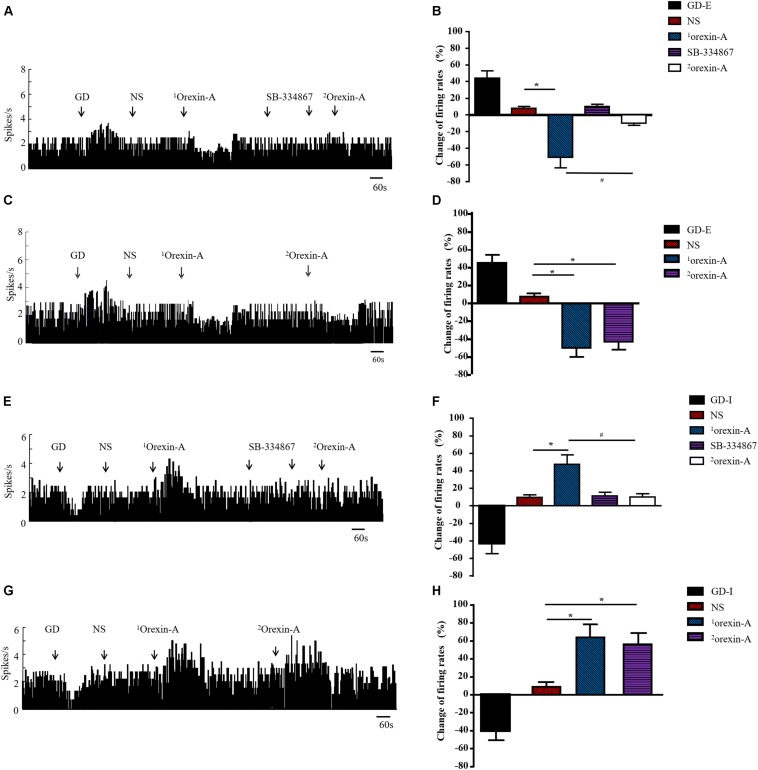
Effect of orexin-A on the discharge of GD neurons in CeA of rats. Typical frequency histograms showed that orexin-A changed discharge rate of GD-E (A) and GD-I (E) neurons in CeA. Pooled data summarized the effects of orexin on GD neurons in CeA (B,F). After pretreatment with SB-334867, the orexin-A induced response was completely blocked and NS or SB-334867 alone had no effect on the firing frequency of GD neurons (A,B,E,F). When orexin-A was given for the second time, it still had inhibitory or excitatory effect on GD-E and GD-I neurons respectively (C,D,G,H). The effect of tested agents on neuronal discharge was calculated by (the maximal change of frequency within 50 s after treatment – average frequency 120 s before treatment)/(average frequency 120 s before treatment) × 100%. Data are shown as mean ± SD. Data were analyzed using Paired Student’s t-test to compare the difference of firing rate before and after treatment and Student’s t-test was used to compare the effect of two different treatment. *P < 0.05, compared with NS; #P < 0.05, compared with 1orexin-A. GD, gastric distension; GD-E, gastric distension excitatory; GD-I, gastric distension inhibitory; NS, normal saline.